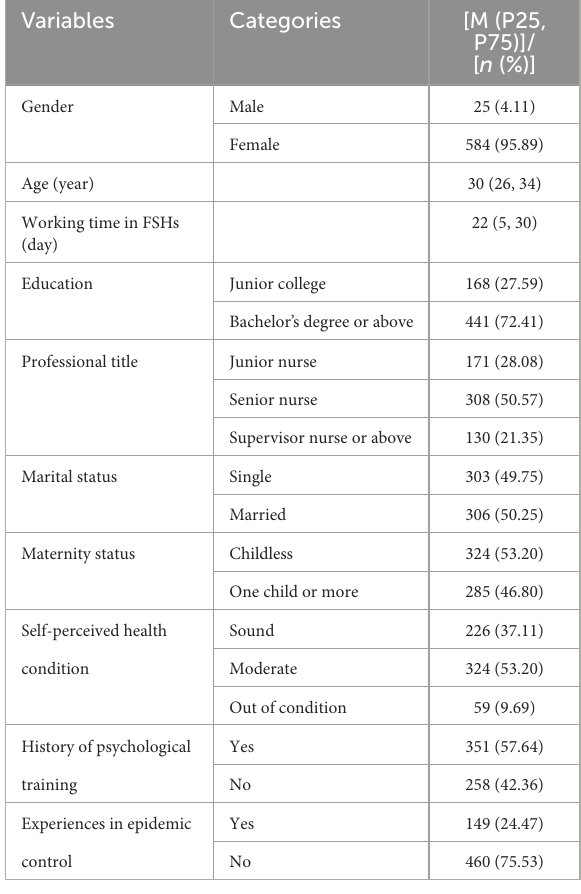
TABLE 1 Socio-demographic characteristics of the sample ( n = 609).